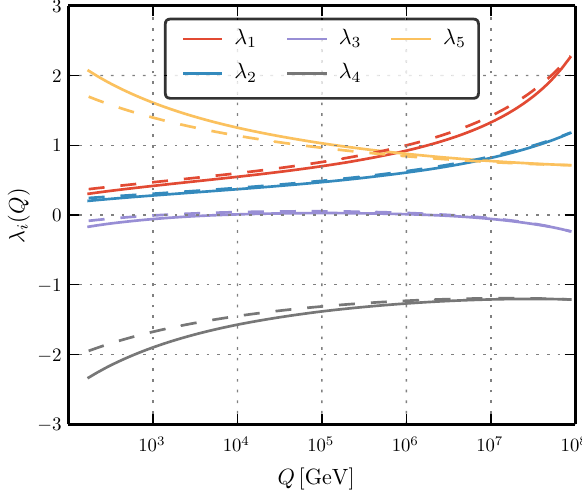
Fig. 2 The RGE running at one-loop (dashed) and two-loop (full) of the quartic couplings λ i when fixing the values at the matching scale of (cid:10) = 10 8 GeV according to